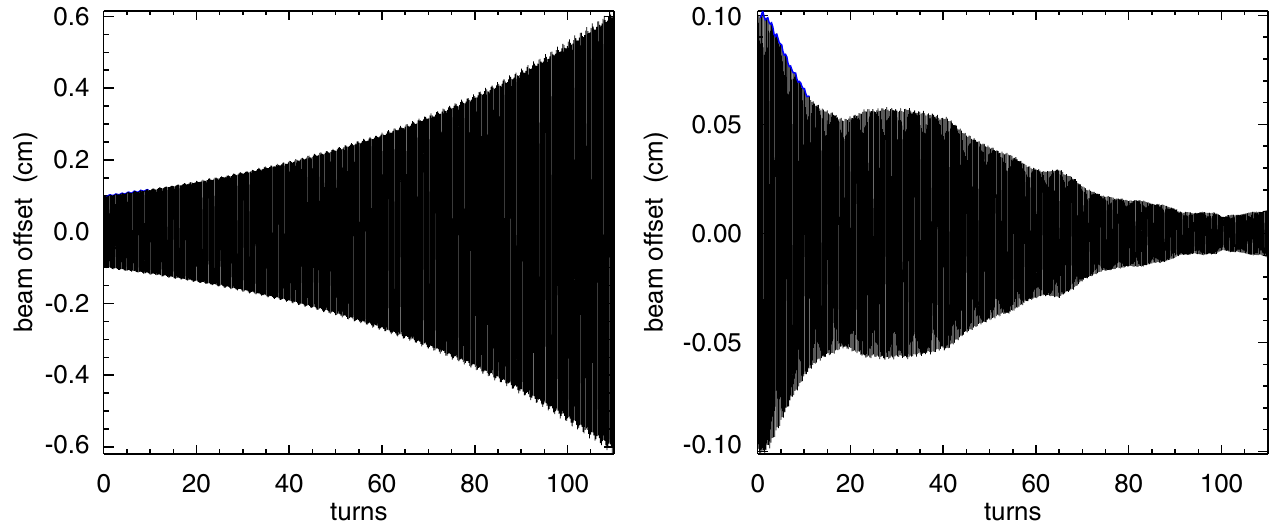
FIG. 1. Representative beam center oscillations from PATRIC simulations for two different Im (cid:1) Z ? (cid:2) and fixed Re (cid:1) Z ? (cid:2) ; left: instability; right: damping dominates (stable). Beam conditions correspond to Fig. 4,